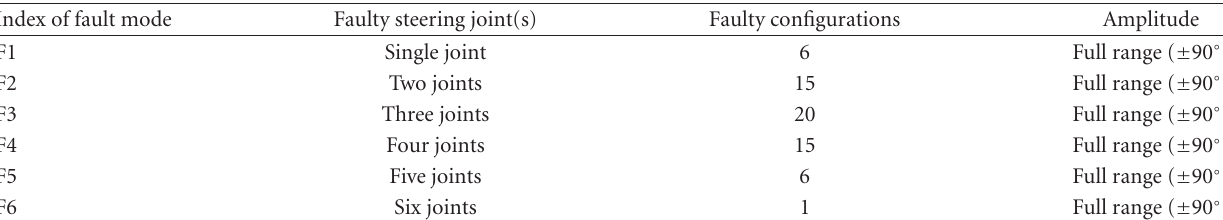
Table 1: Fault repertory